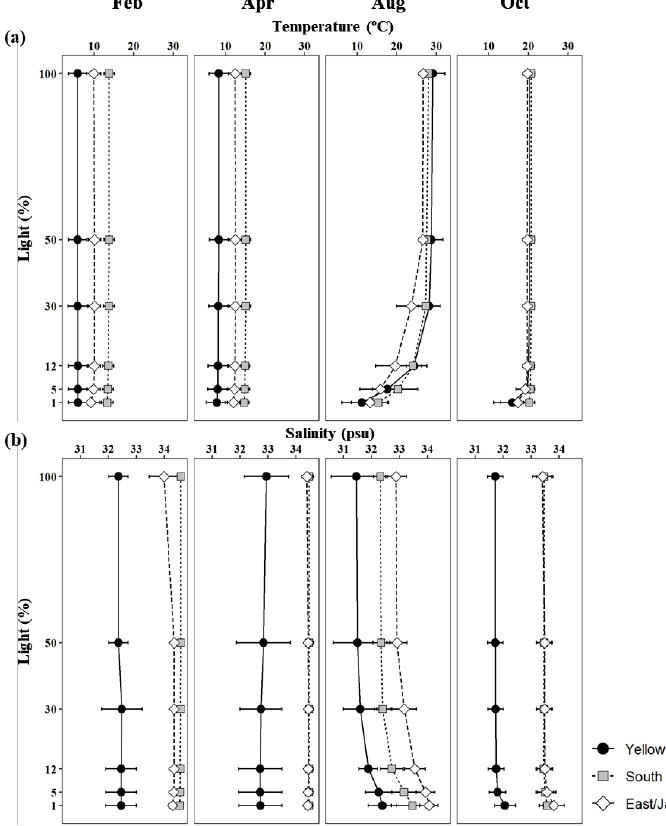
Figure 2. Vertical profiles of mean temperatures ( a ) and salinities ( b ) at six light depths (100, 50, 30, 12, 5, and 1%) in the YS, the SS, and the EJS, 2018. The mean euphotic depths in the YS, the SS, and the EJS were deepest in August at 37.6 ± 15.6, 49.8 ± 11.3, and 54.4 ± 10.7 m, respectively (Figure 3). In particular, the euphotic depth in the EJS in February (51.0 ± 5.8 m) was significantly deeper (one-way ANOVA, p < 0.01) than those in the YS (12.8 ± 6.2 m) and the SS (28.1 ± 4.7 m). The deepest MLDs in the YS, the SS, and the EJS were observed in February, with means of 68.7 ± 15.7, 59.0 ± 40.5, and 80.6 ± 57.4 m, respectively (Figure 3). The MLDs in the YS, the SS, and the EJS became continuously shallow until August at 12.0 ± 14.2, 13.7 ± 6.6, and 13.2 ± 6.2 m, respectively, and then deepened in October to 26.3 ± 13.7, 30.2 ± 16.1, and 37.9 ± 14.2 m, respectively. In all regions, the differences between the MLDs and euphotic depths were greatest in February, decreased toward April, and then reversed in August when MLDs were significantly shallower than the euphotic depths ( t -test, p < 0.01) (Figure 3). These results indicate that the euphotic zone was vertically well-mixed in all study regions during February and April, whereas strong stratifications were developed in the euphotic water columns during